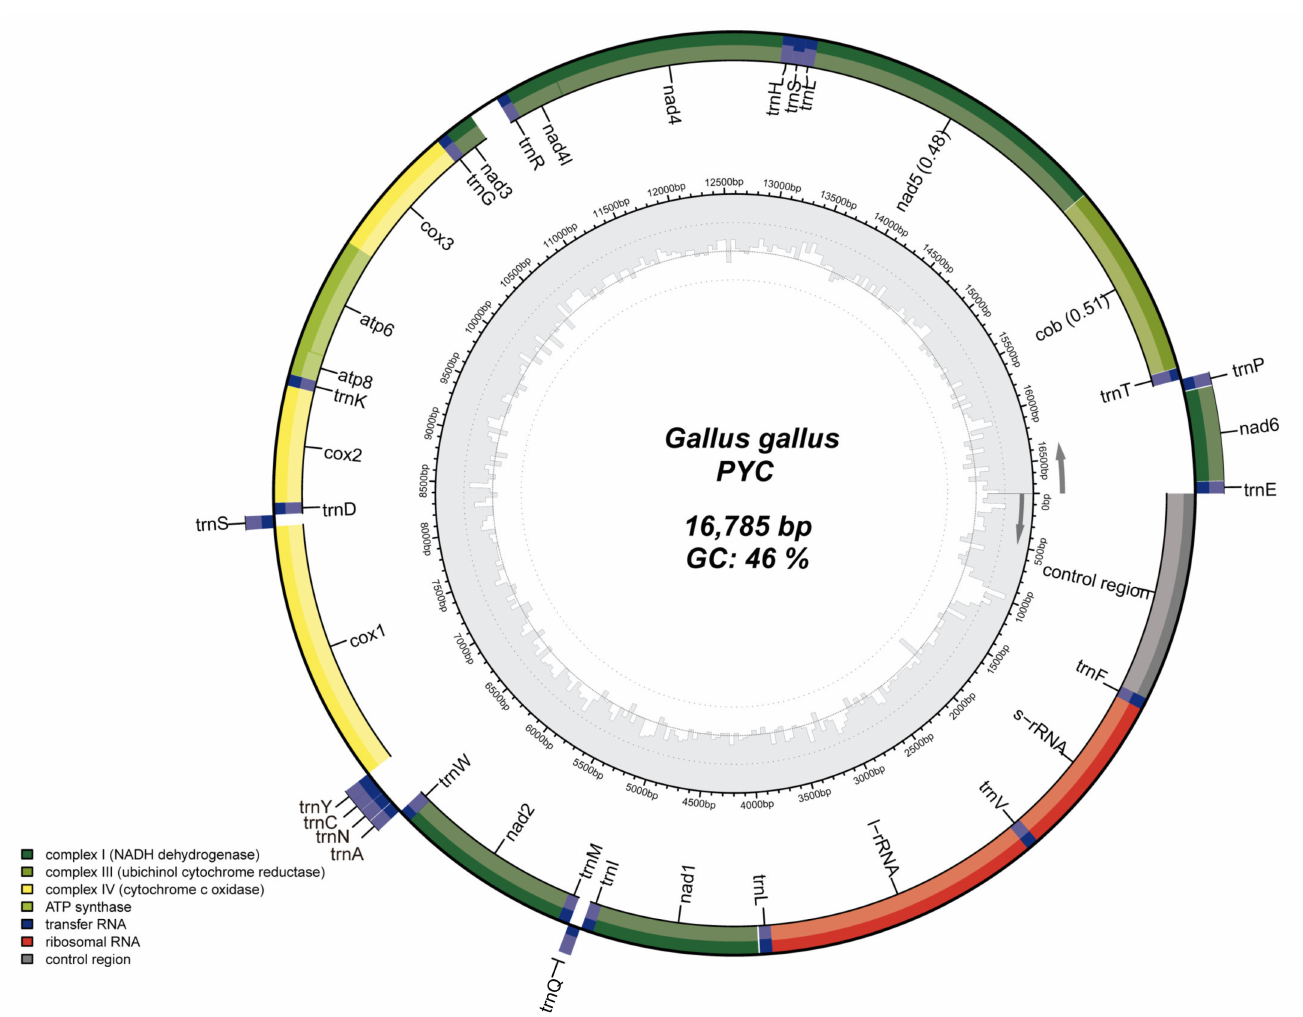
Figure 2. Mitochondrial genome structure of the Pingpu Yellow chicken. Genes in the inner circle plot are located on the N-strand, and the rest of the genes are located on the J-strand. Dark green, light green, and yellow represent PCGs coding complex I, III, and IV, respectively. ATP synthase, rRNA, tRNA genes, and the control region are colored with olive green, red, dark blue, and gray,